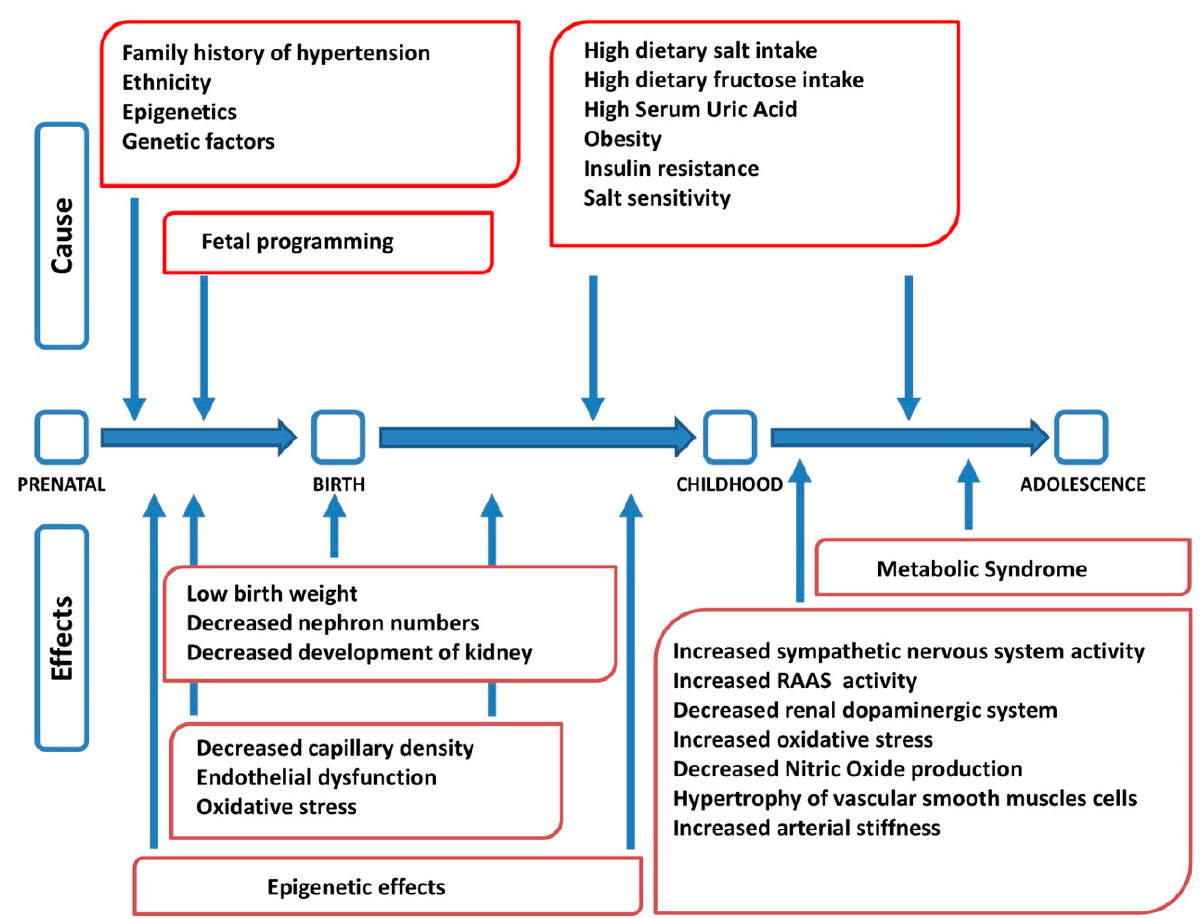
Figure 1. Factors interacting in the pathogenesis of arterial hypertension at different stages of life (modified from [23]). RAAS: renin angiotensin aldosterone system.